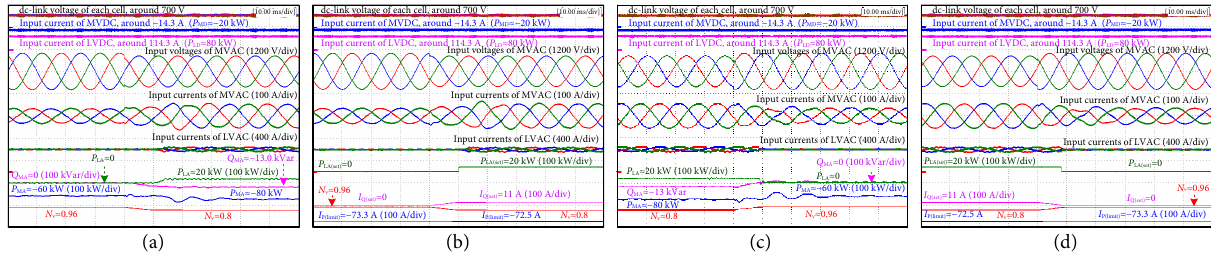
dc-link voltage of each cell, around 700 V Input current of MVDC, around −14.3 A ( P MD ≈−20 kW) Input current of LVDC, around 114.3 A ( P LD ≈80 kW)